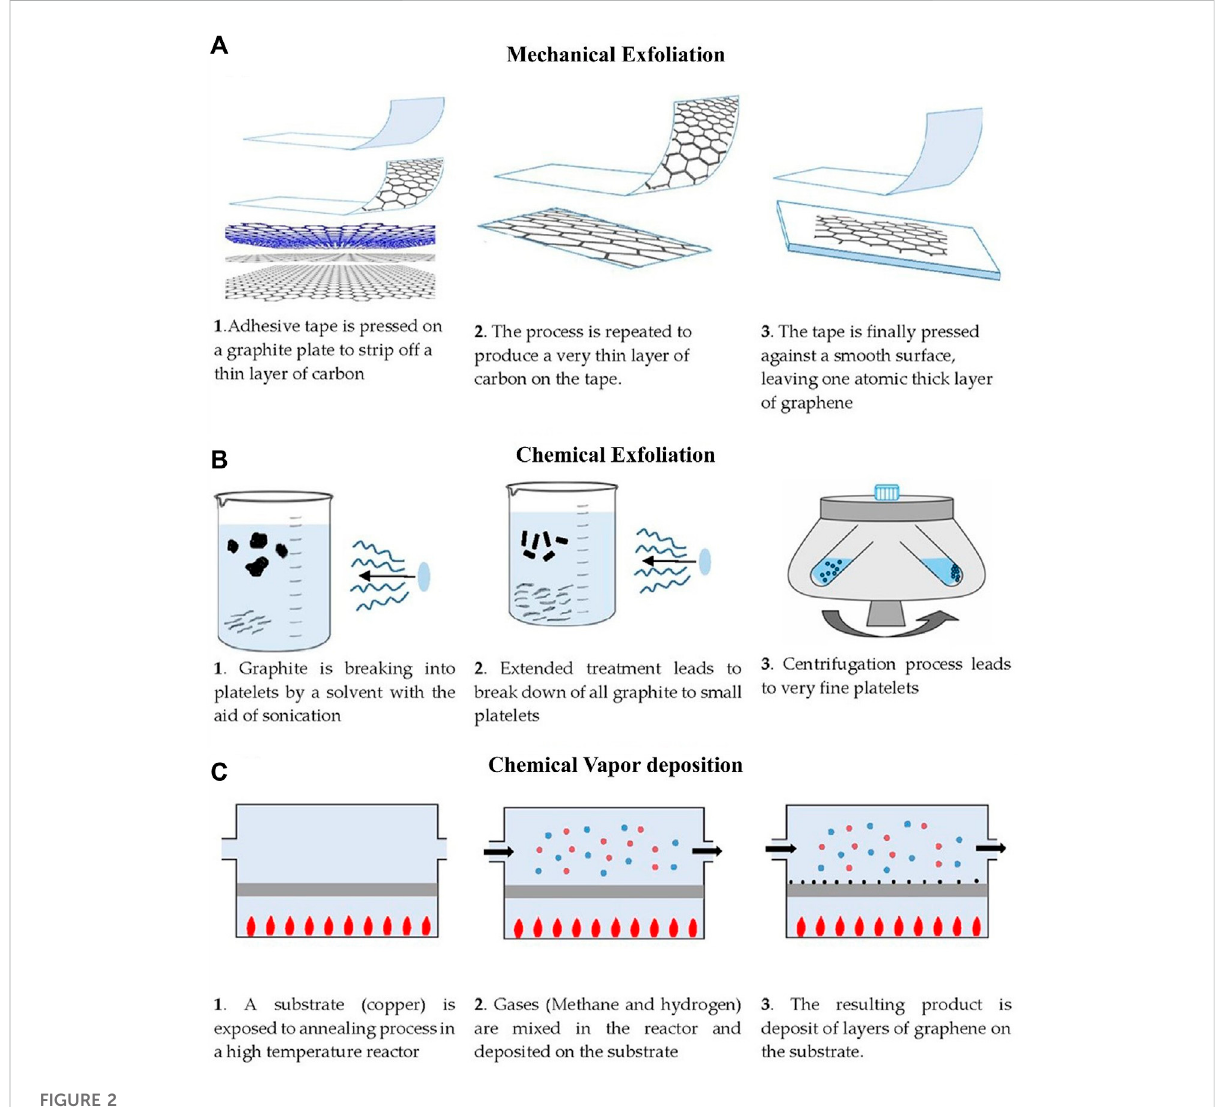
FIGURE 2 The main graphene production strategies are depicted in this diagram. (A) Exfoliation by mechanical means, (B) Liquid-phase chemical exfoliation (C) Chemical vapour deposition (CVD).